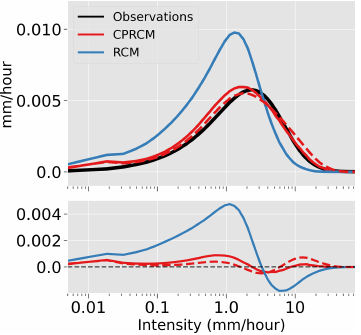
Figure 5. The top panel shows the contributions per intensity bin to the total June–August mean precipitation over Sweden, in mil- limetres per hour. The observations are from a combined radar– rain gauge data set. The lower panel shows the differences with respect to the observations. The coarse-scale RCM is operated at a 12km horizontal resolution, whereas the convection-permitting RCM (CPRCM) runs at 3km. The CPRCM data are shown at both the native resolution (dashed) and remapped to the RCM grid (solid). The figure has been modified from Lind et al.